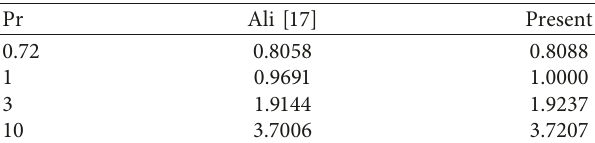
Table 1: Comparison of − f ″ ( 0 ) for various values of δ when